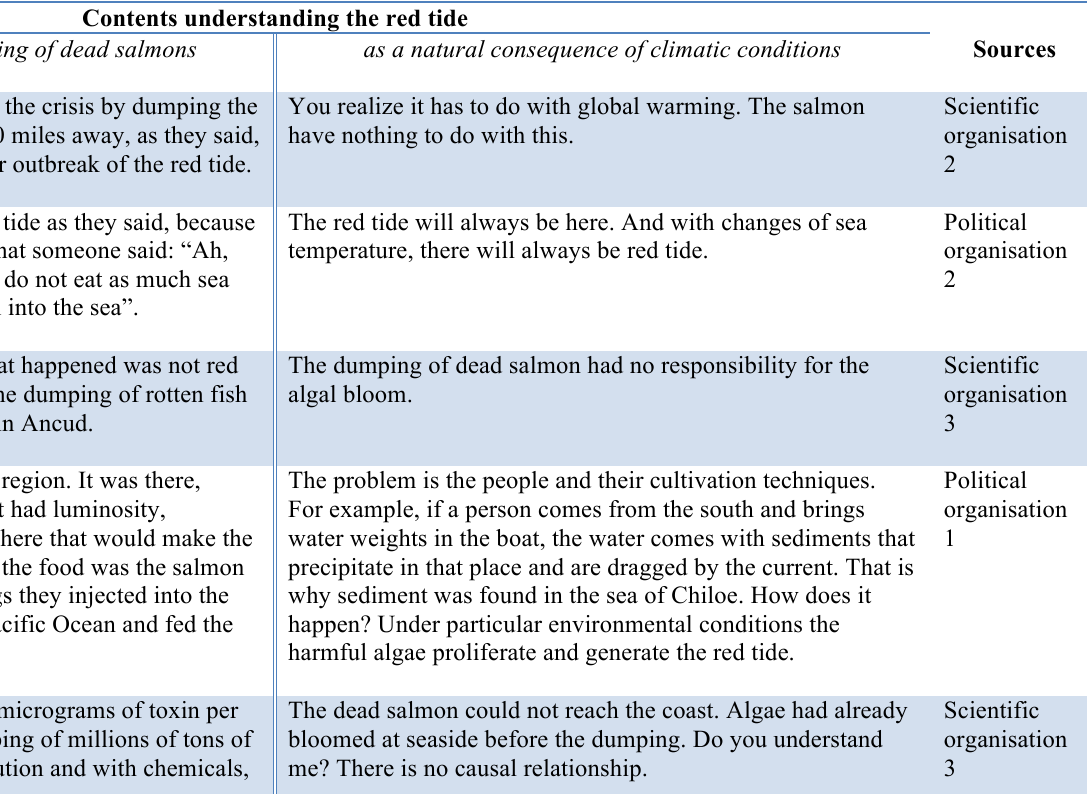
Table A2.2 Controversial sentences from in-depth interviews on the topic ‘red tide’ (including selected material from key